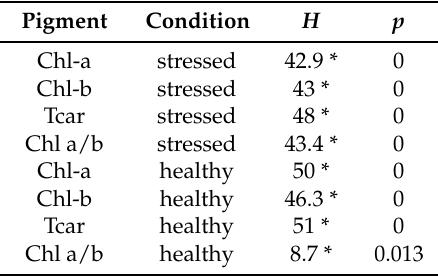
Comparing the samples from the Avicennia germinans , Laguncularia racemosa , and Rhizophora mangle , mangrove species using a Kruskal–Wallis H -test for the pigments ( n = 30) during the rainy season. * Significant H value at α =